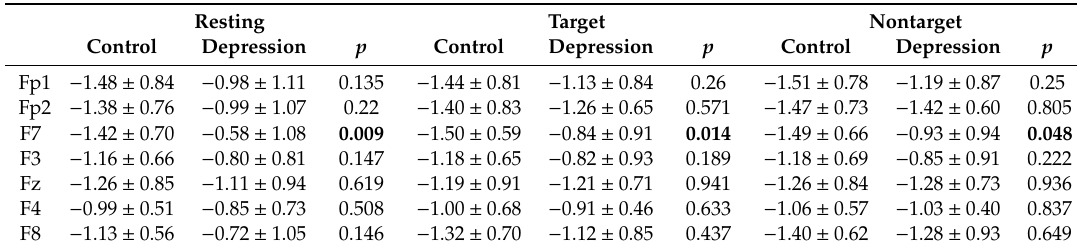
Table 3. T-test results of di ff erences between the MDD and control groups regarding cordance in the theta band channels.